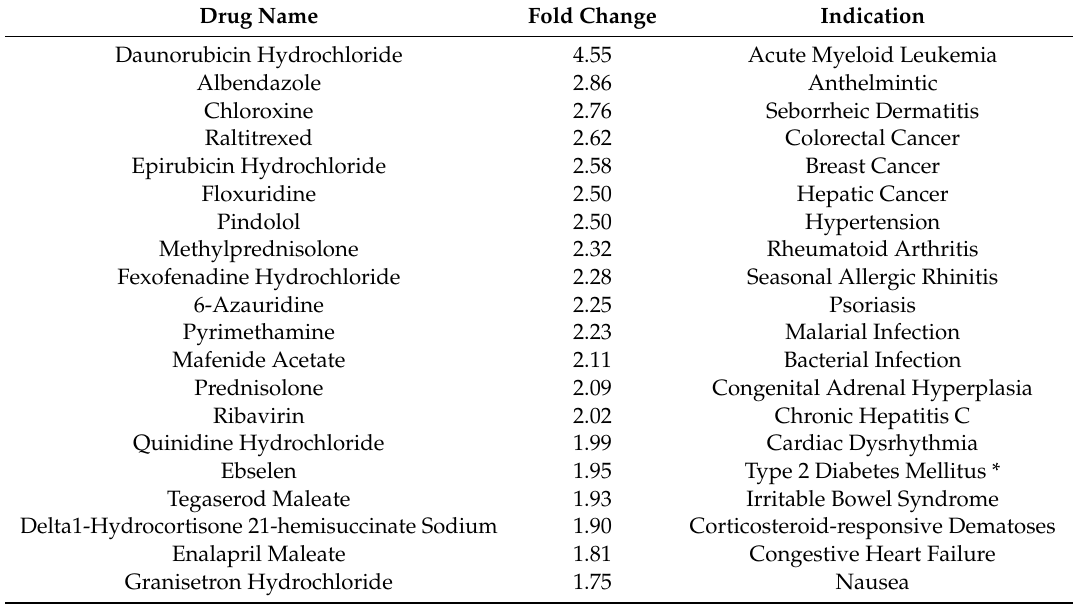
Table 1. Top 20 FDA-approved drugs that positively modulate HbF in K562 s.